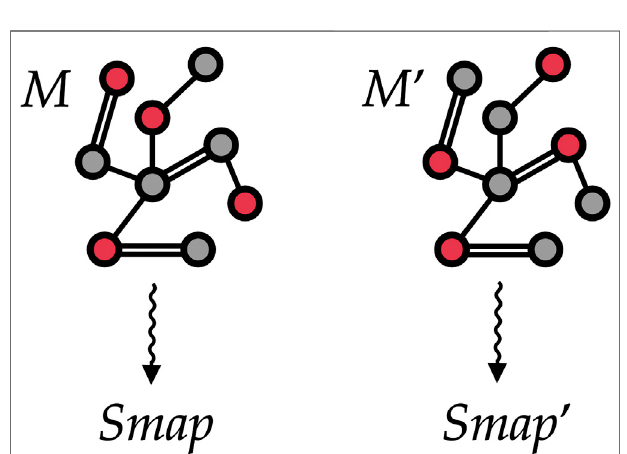
Figure 5 — corresponding to different values of S map . In enrich each vertex with 10 features,